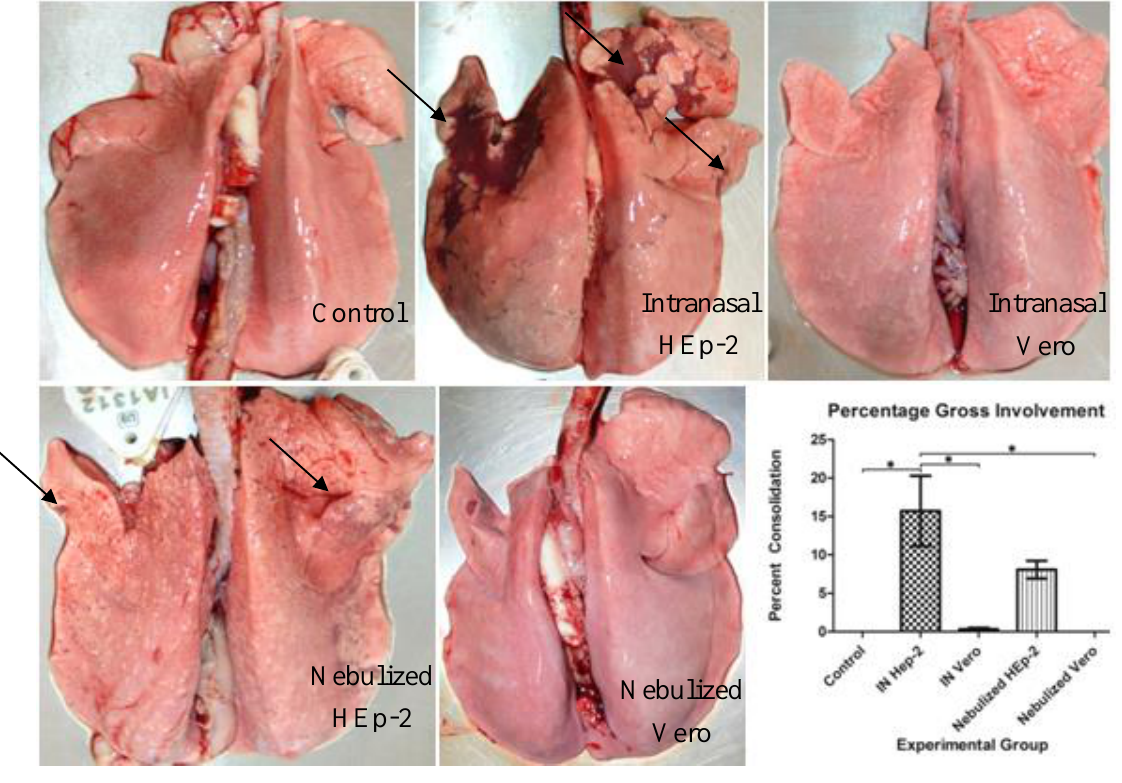
Figure 3. Gross lesions of infected lambs. Arrows indicate viral lesions characterized by reddened regions of consolidation. The intranasal HEp-2 (INH) group had significantly more gross involvement than control, intranasal Vero (INV), or nebulized Vero (NeV)